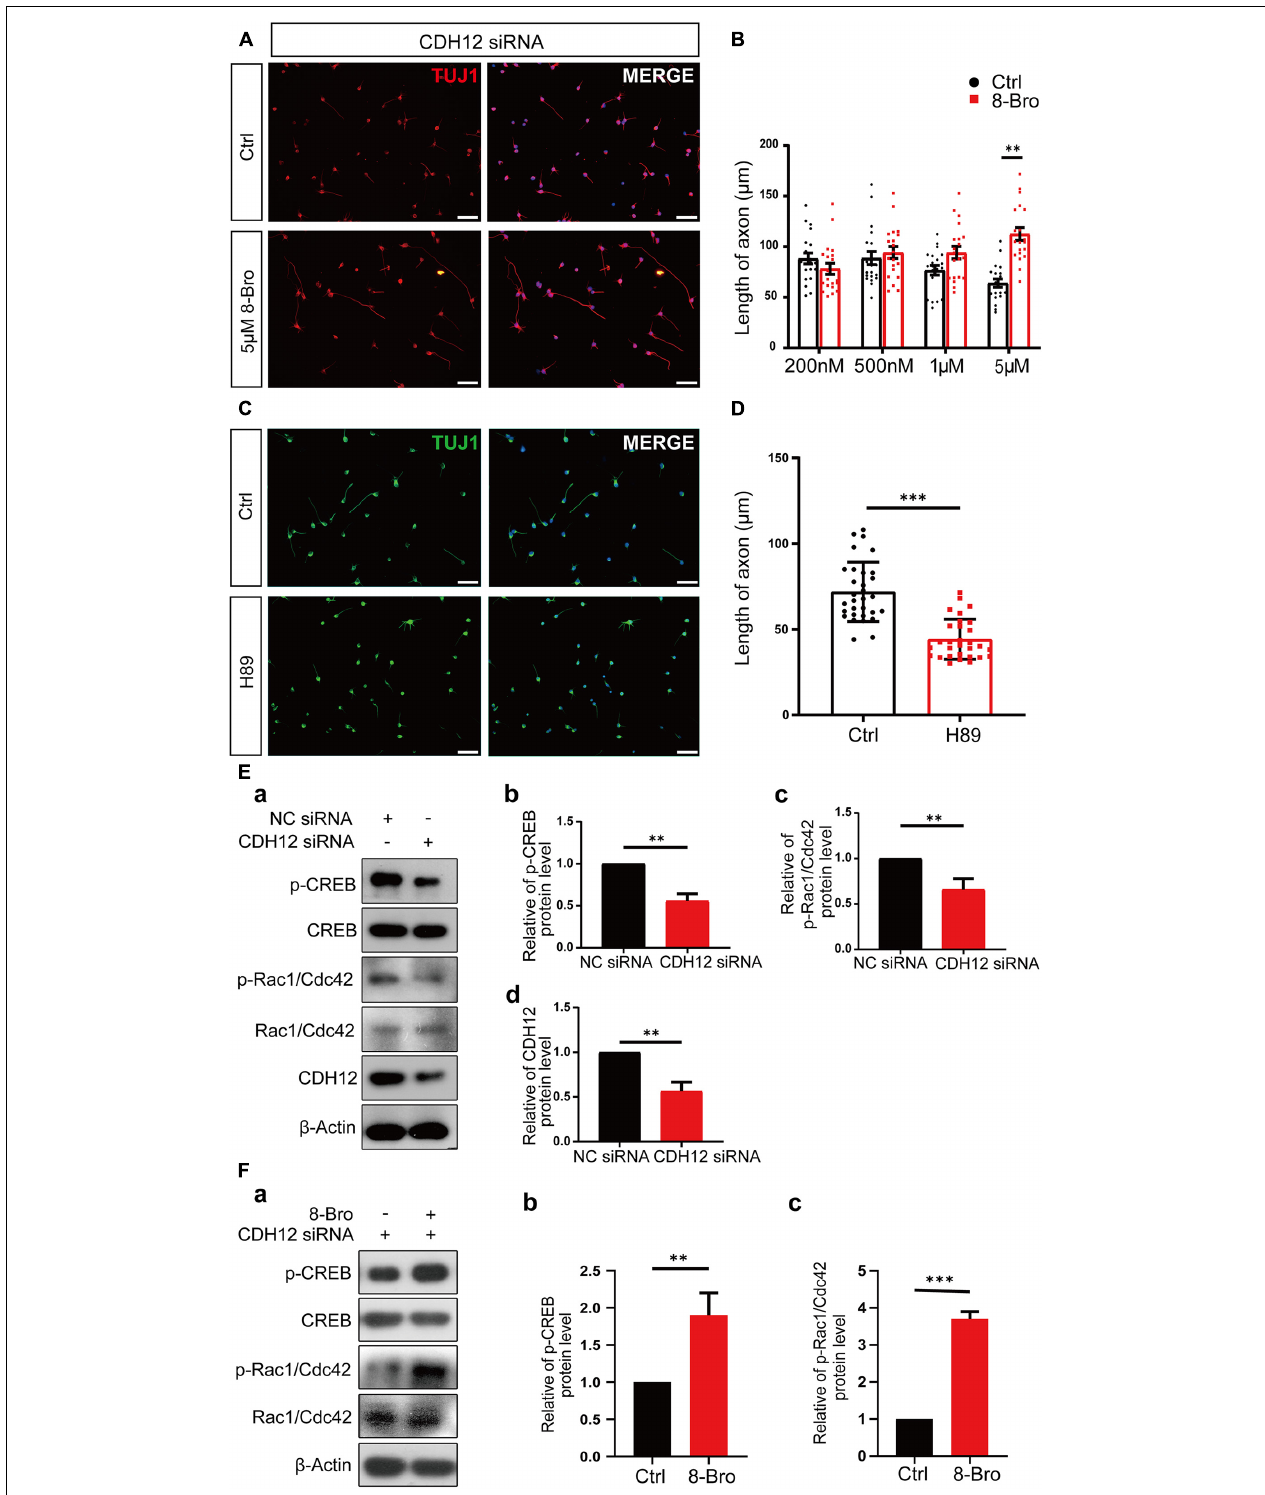
FIGURE 3 | CDH12 regulates neuronal growth via the PKA/Rac1/Cdc42 pathway. (A,B) PKA agonist (8-Bro) could rescue the CDH12 knockdown phenotype when its concentration reached 5 µ M. The scale bar represents 75 µ m. The statistical data show the mean ± SE. n = 20, ∗∗ P < 0.01. (C) Representative images of Tuj1 immunostaining in neurons treated with control (Ctrl) or H89 (3 µ M) for 12 h. The scale bar represents 75 µ m. (D) The statistical result of axonal length after treatment with the negative control or H89 (3 µ M) in E18 neurons. The data shown are the mean ± SE. n = 30, ∗∗∗ P < 0.001. (E) CDH12 regulates neuronal growth